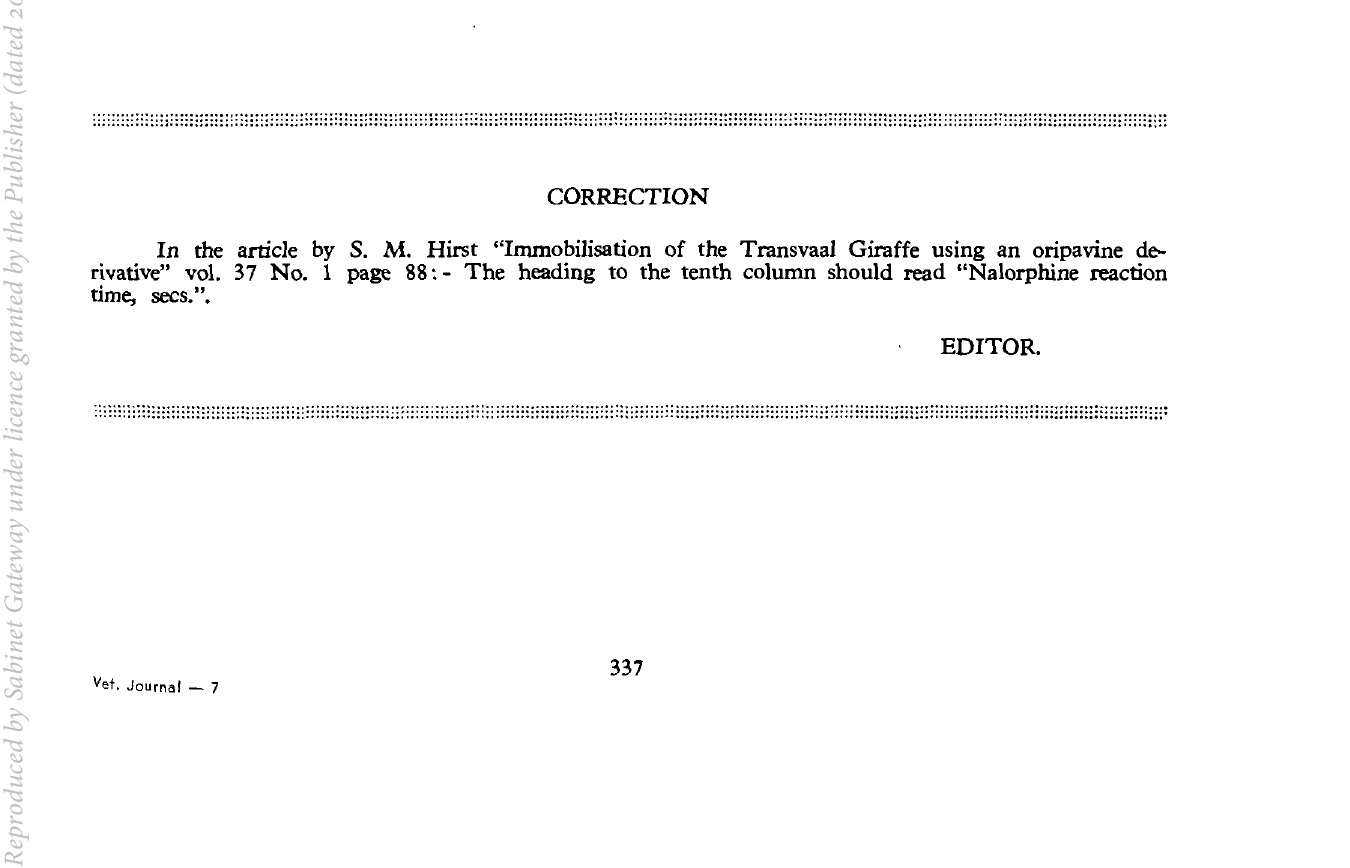
(f)F. DE ST. J. VAN DER RIET. (1960). Ondersoek na EnsoOtiese Ikterus: Fraserburg Dist. 12-14 Desember 1960. Rept. to Sub-Dir. Vet. Servo Cape West. (g) HUGO, W. J. (1962). Ensootiese Ikterus. Rept. to Dir. Vet. Servo (Field), Pretoria. 15. BELONJE, C. W. A. (1958). JI. S. Afr. Vet. Med. Assoc. 29,